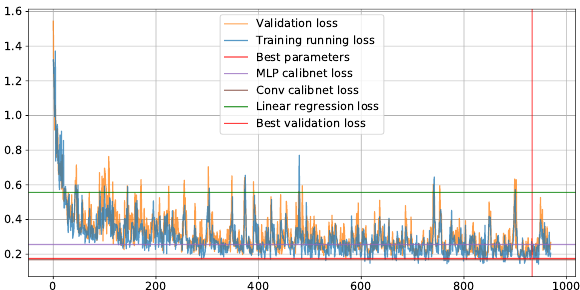
Figure 9. Evolution of training and validation losses during BCNet network training on datasets Aude1. Green line indicates loss achieved by linear regression, purple line indicates loss achieved by CalibNet, and brown line loss achieved by ConvCalibNet (those two last lines are superimposed in the graph). Red lines indicate best loss and iterations.